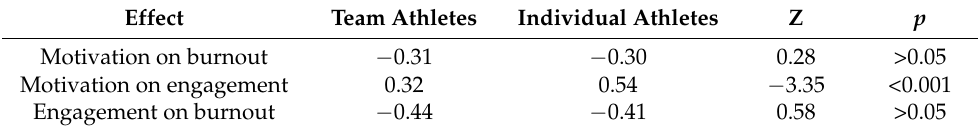
Table 4. Comparison of effects between athletes participating in team and individual